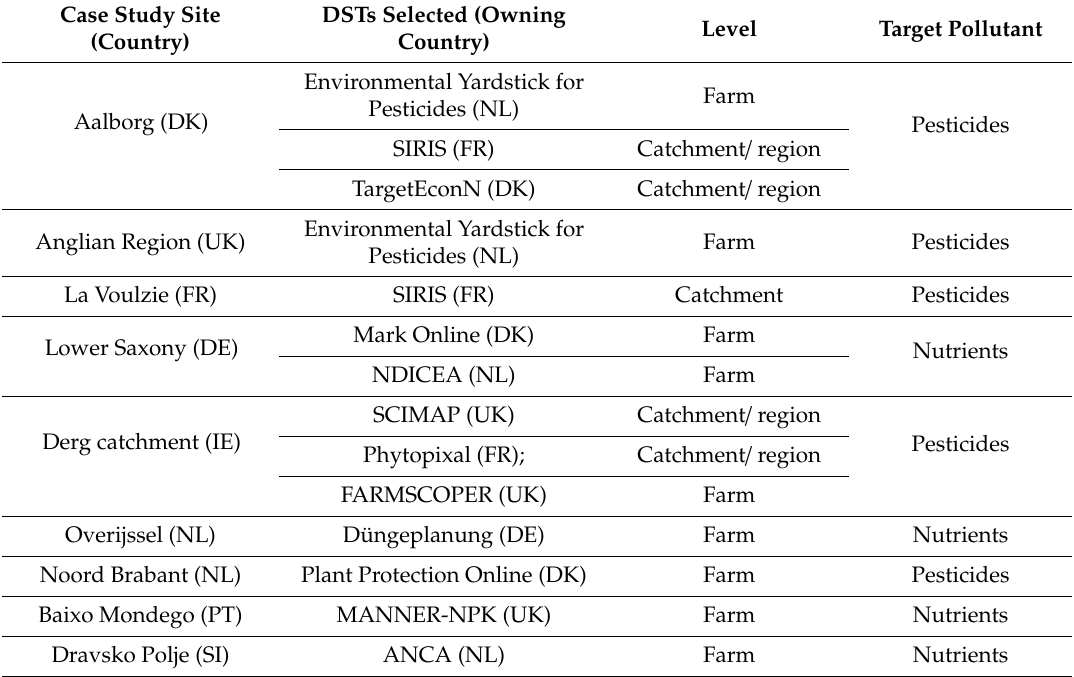
Table 3. DSTs selected for testing and / or demonstration by the nine participating FAIRWAY case study